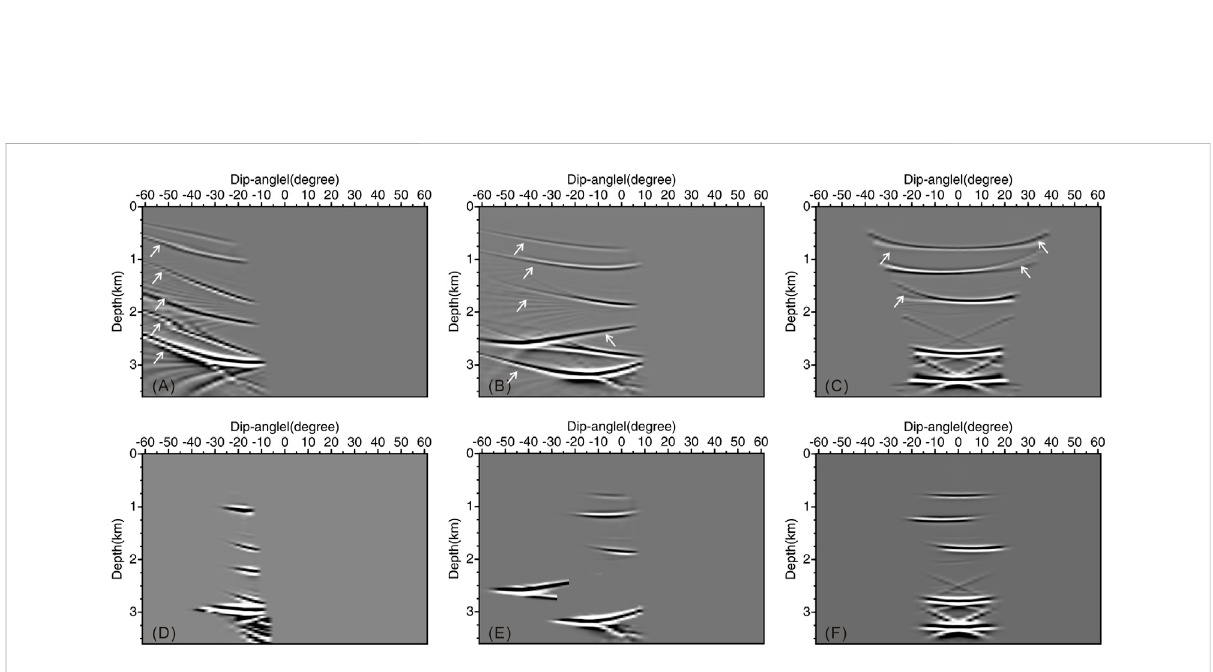
FIGURE 8 The DDCIGs of the graben model data produced by DDGRT at the lateral position of (A) x = 510 m, (B) x = 1,300 m, and (C) x = 2000 m. (D – F) are the DDCIGs produced by weighted DDGRT at the same lateral position.